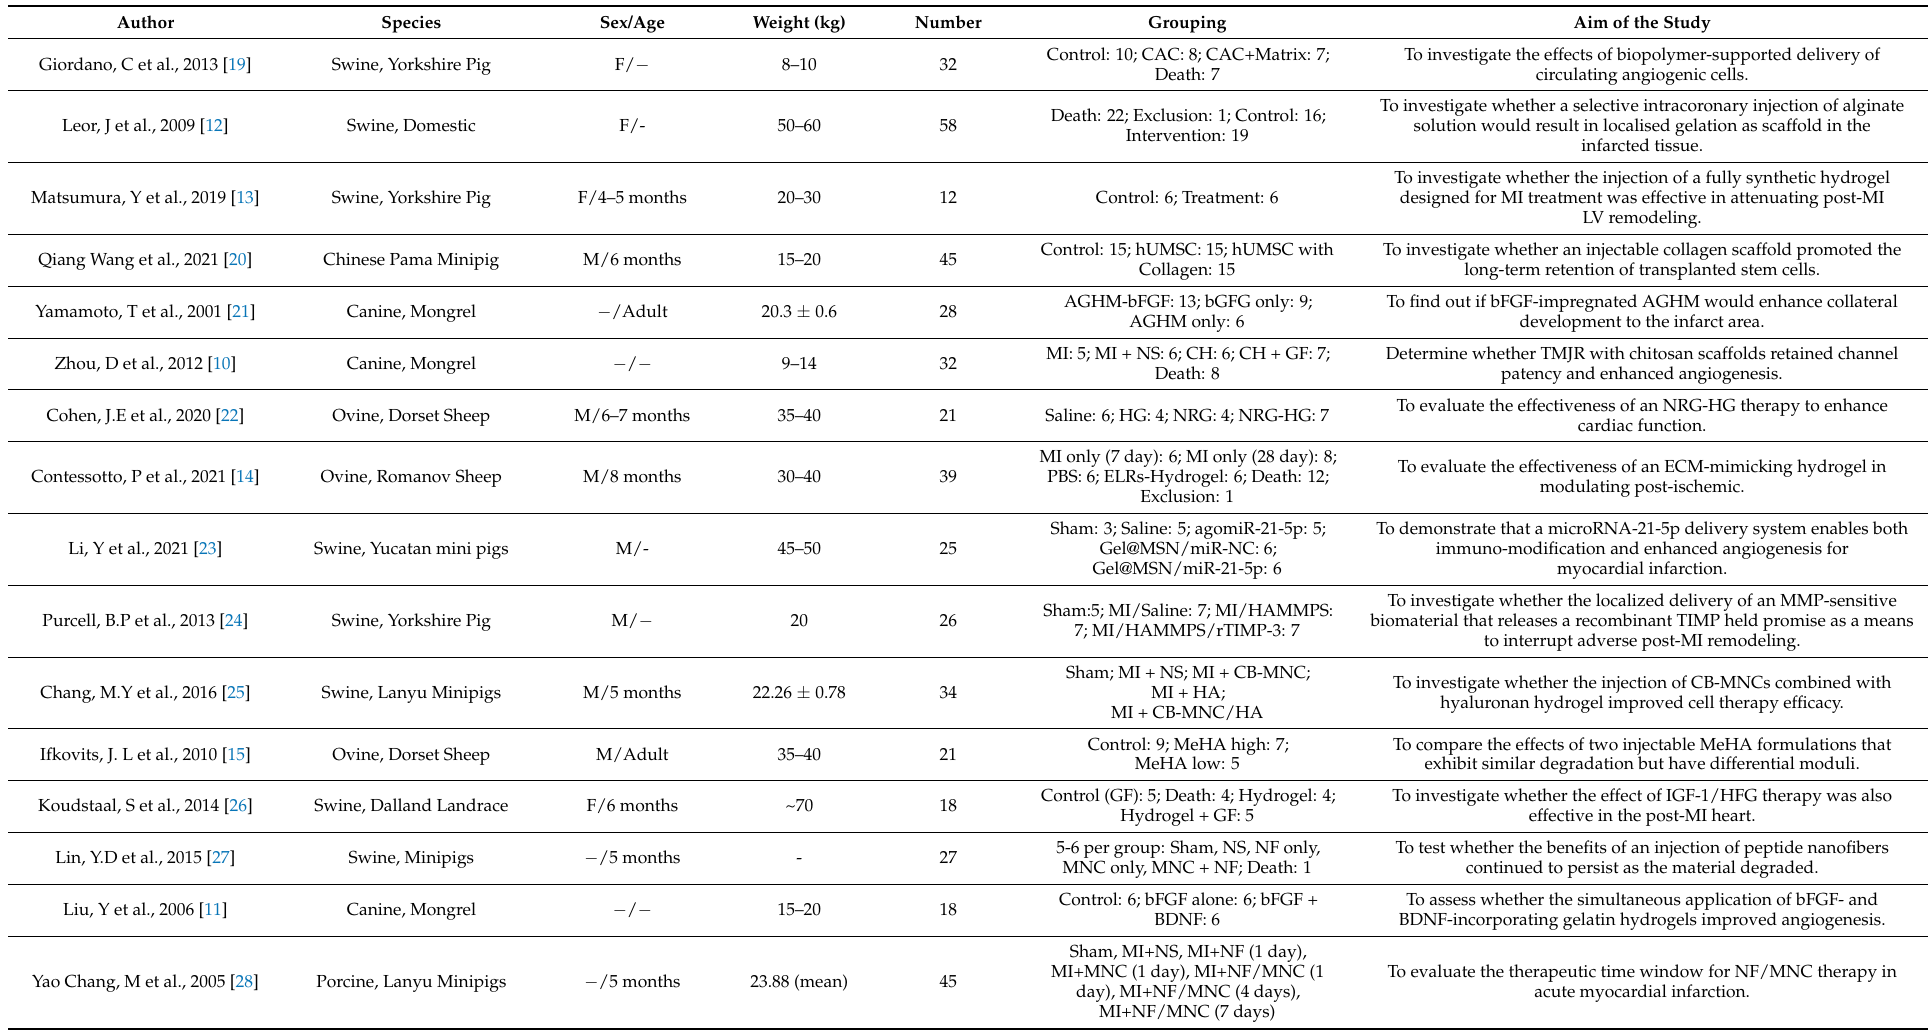
Table 1. Characteristics of the included